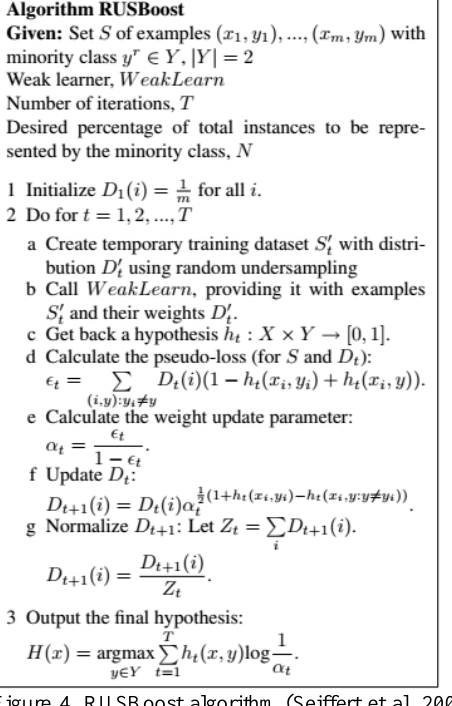
Figure 4. RUSBoost algorithm (Seiffert et al. 2008; Seiffert et al. 2010)